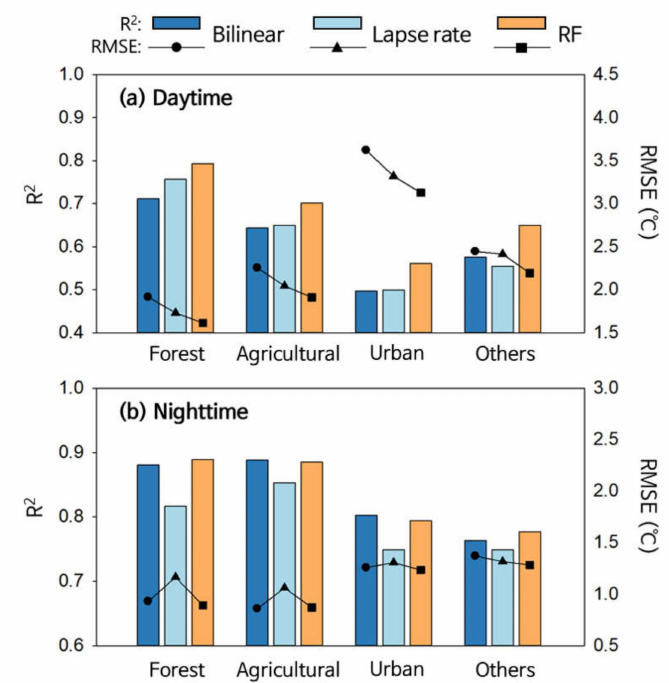
Figure 6. Model performance of three downscaling approaches (bilinear resampling (bilinear), lapse rate, and random forest (RF)) in the second step for scheme 1 by land cover for daytime ( a ) and nighttime ( b